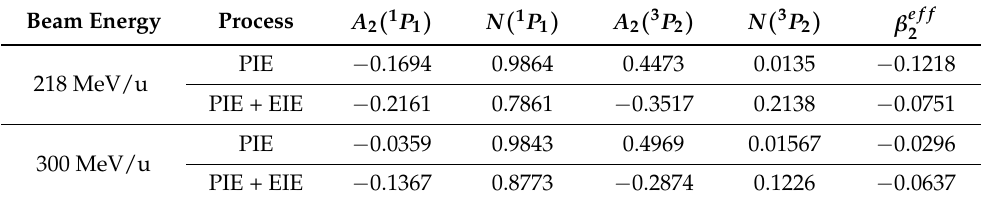
Table 1. Theoretical values for the alignment parameters A 2 , the relative populations N , and the resulting effective anisotropy parameters β ef f for [ 1 s 1/2 ,2 p 3/2 ] 1 P 1 and [ 1 s 1/2 ,2 p 3/2 ] 3 P 2 states 2 contributing to the K α 1 line. For details see text.